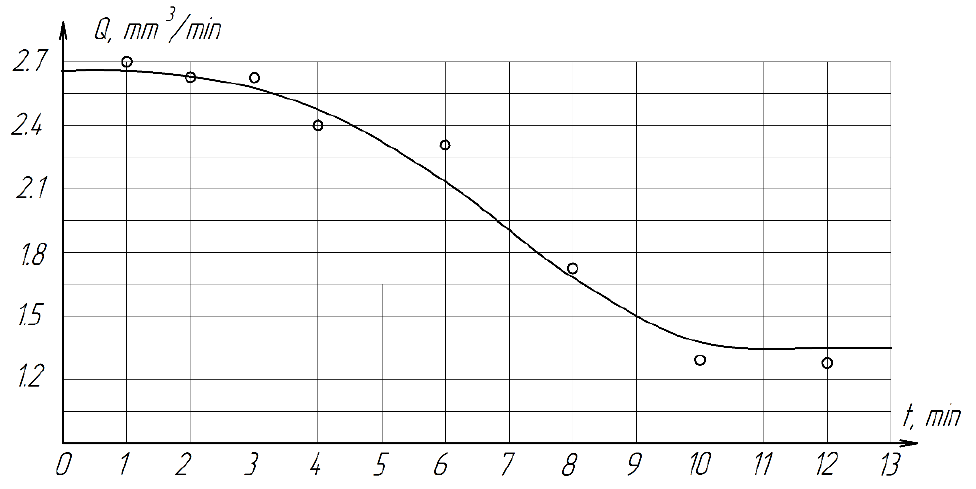
Figure 12. The effect of the total processing time T on productivity. Ra 0.1807 µ m to Ra 0.1322 µ m, which is associated with the gradual grinding of abrasive grains (Figure 13).